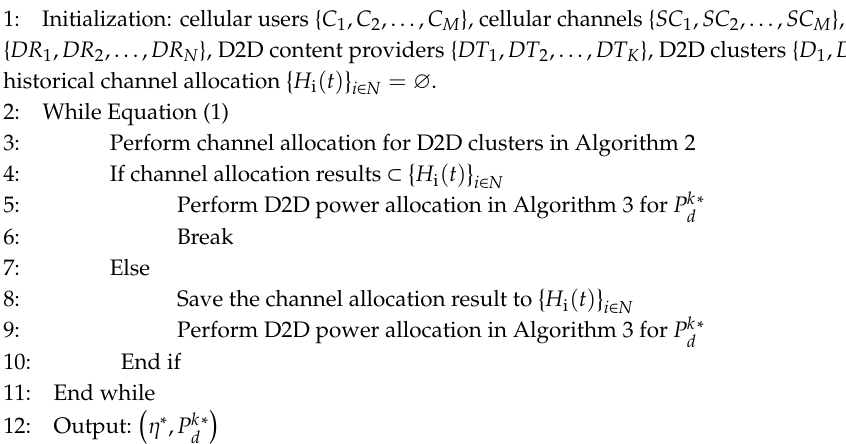
Algorithm 4 Joint optimization method for resource